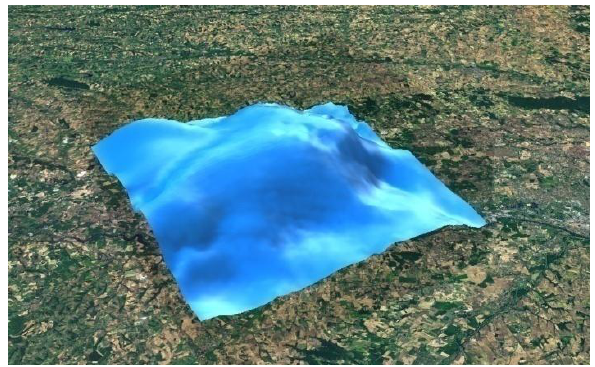
Figure 9 – Isosurface rendering of volume data